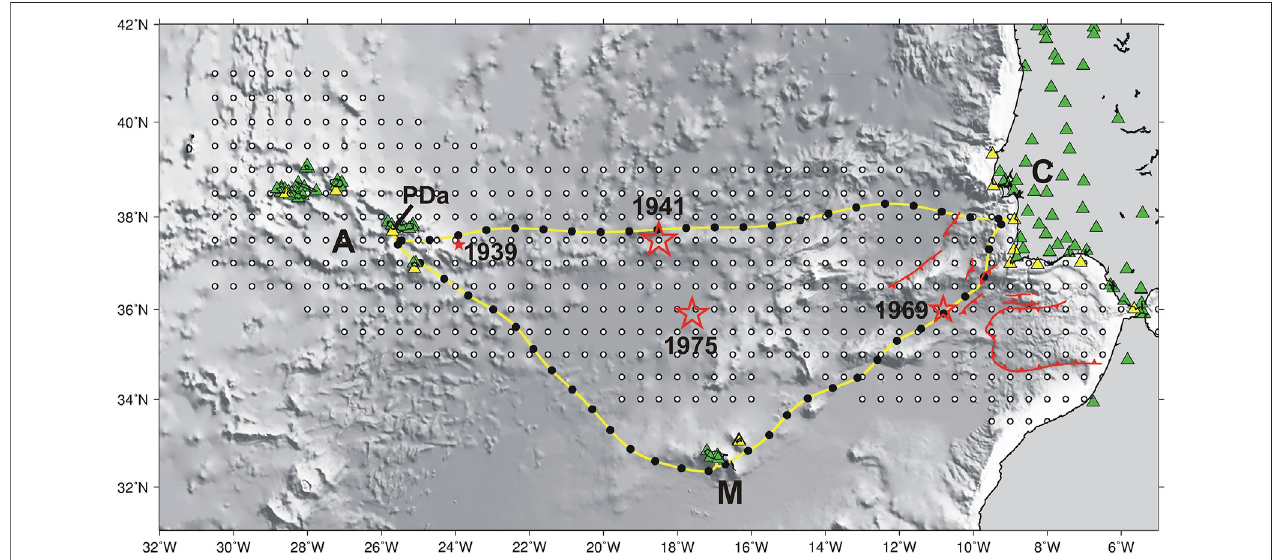
FIGURE 3 | Hypothesized location of the submarine telecom cables that are expected to begin operation in 2024 in yellow. The black dots mark the presumed location of telecom repeaters, every 70 km spaced offshore, with the fi rst repeater 40 km from the shoreline. The red stars show the epicenter location of the largest earthquakes that occurred in the area since 1940, 1941, 1975, and 1969. Several tectonic structures (in red) have been proposed SW Iberia as the source of the large earthquake and tsunami the November 1 st , 1755. The smallest red star shows the location of the May 8 th 1939 (Ms7.1) earthquake that caused a small tsunami recorded in several tide gauges in the Azores. Green triangles show the location of the land seismic stations used by IPMA for earthquake monitoring. PDa – Ponta Delgadatidegauge.YellowtrianglesshowthelocationofthecoastaltidegaugesthataremonitoredbyIPMAfortsunamiearlywarning.Thewhitedotsshowthelocation of the tsunami sources in the IPMA scenario database, spaced every half a degree (Annunziato et al., 2009).